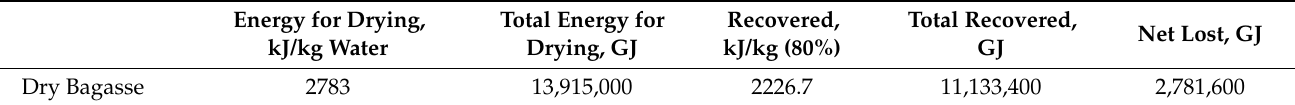
Table 23. Energy required for drying bagasse.